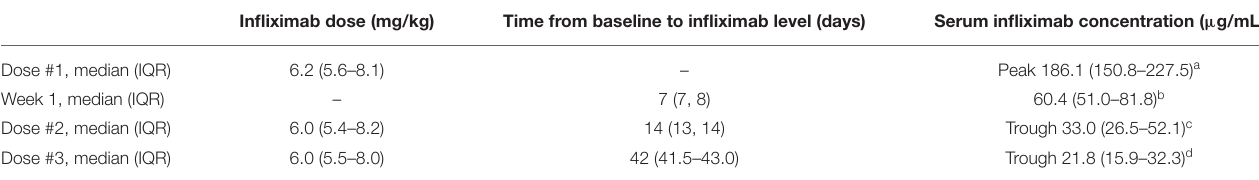
TABLE 2 | Infliximab schedule and serum infliximab concentration. Infliximab dose (mg/kg) Time from baseline to infliximab level (days)